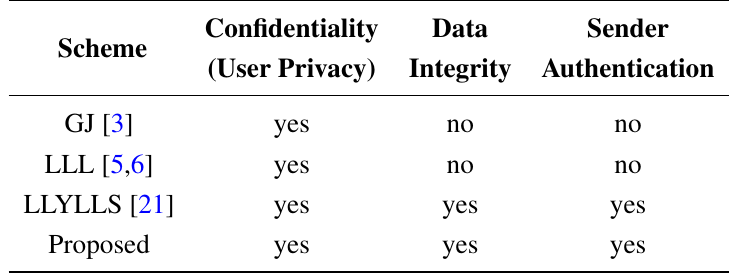
Table 1. Security property